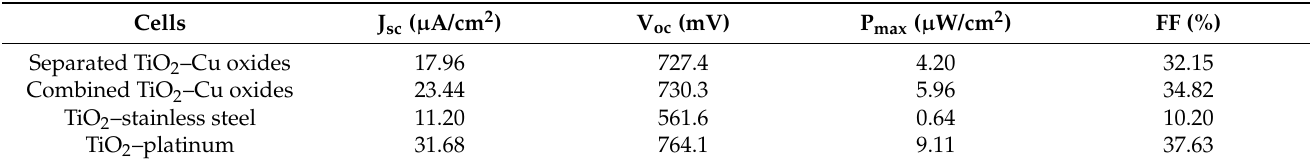
Table 1. P, I, and V values of the cells under